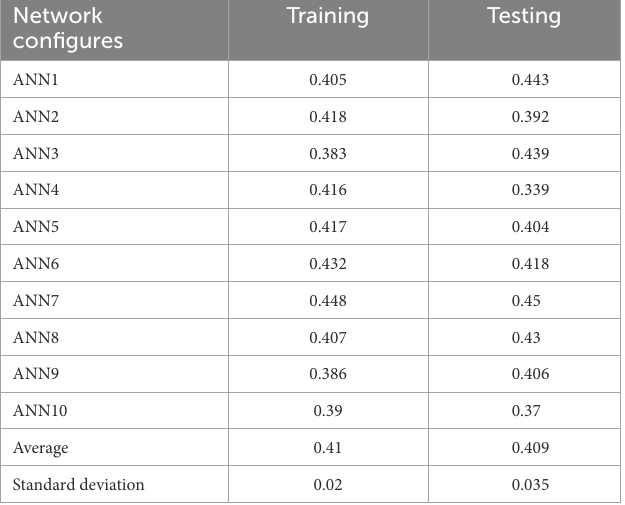
TABLE 7 Validation results of ANN model (RMSE values).